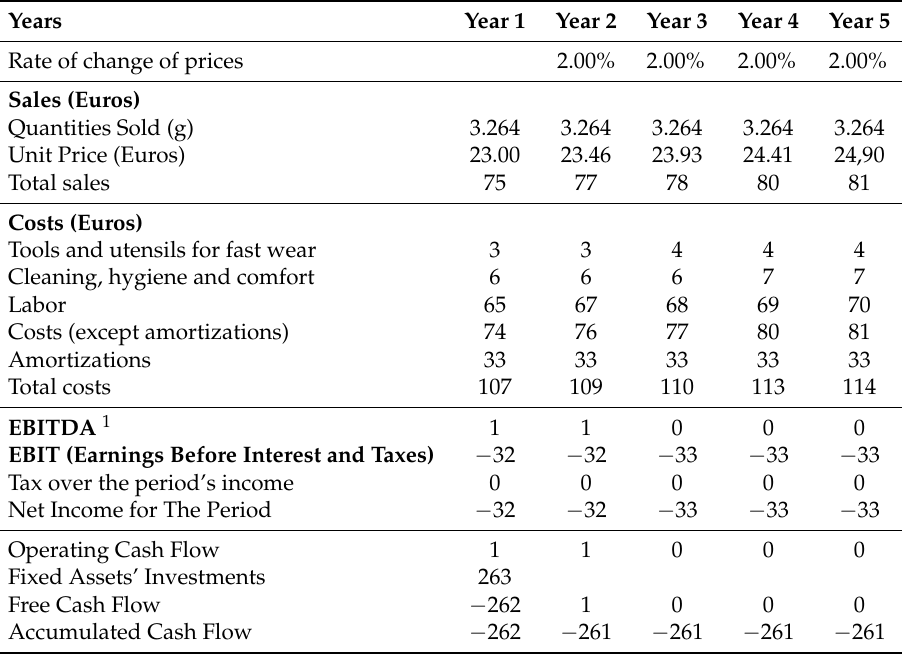
Table 7. State-of-the-art